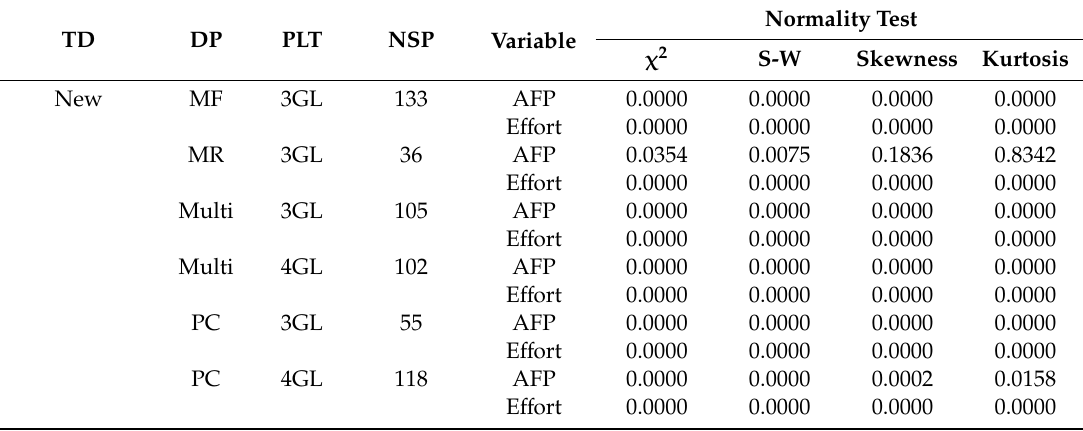
Table 5. Normal statistical tests by data set (NSP: number of software projects; S-W: Shapiro-Wilk). TD DP PLT NSP Variable